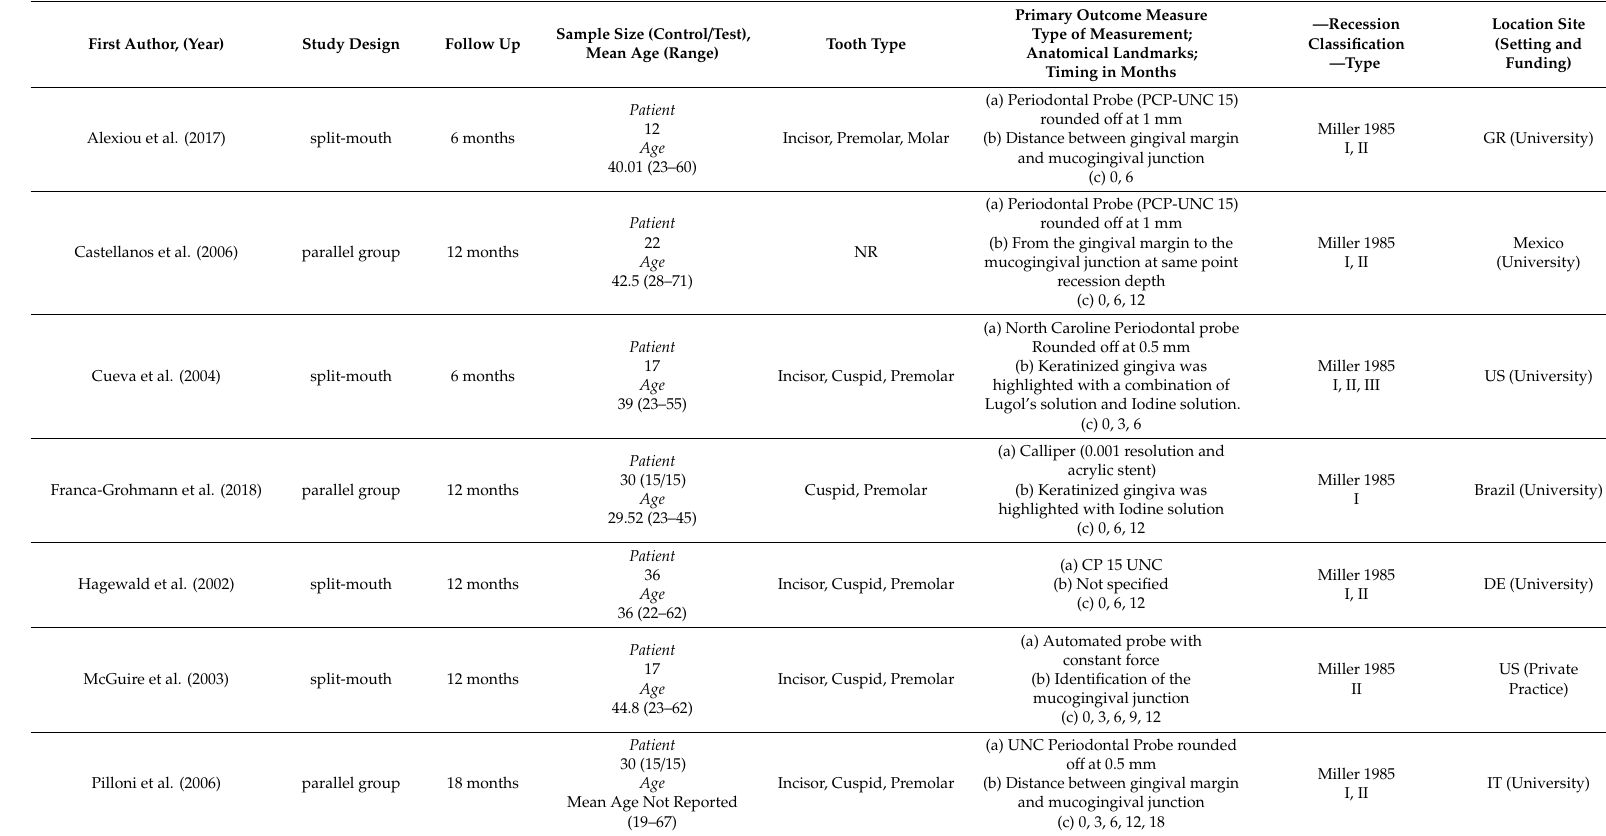
Table 1. General overview of the included